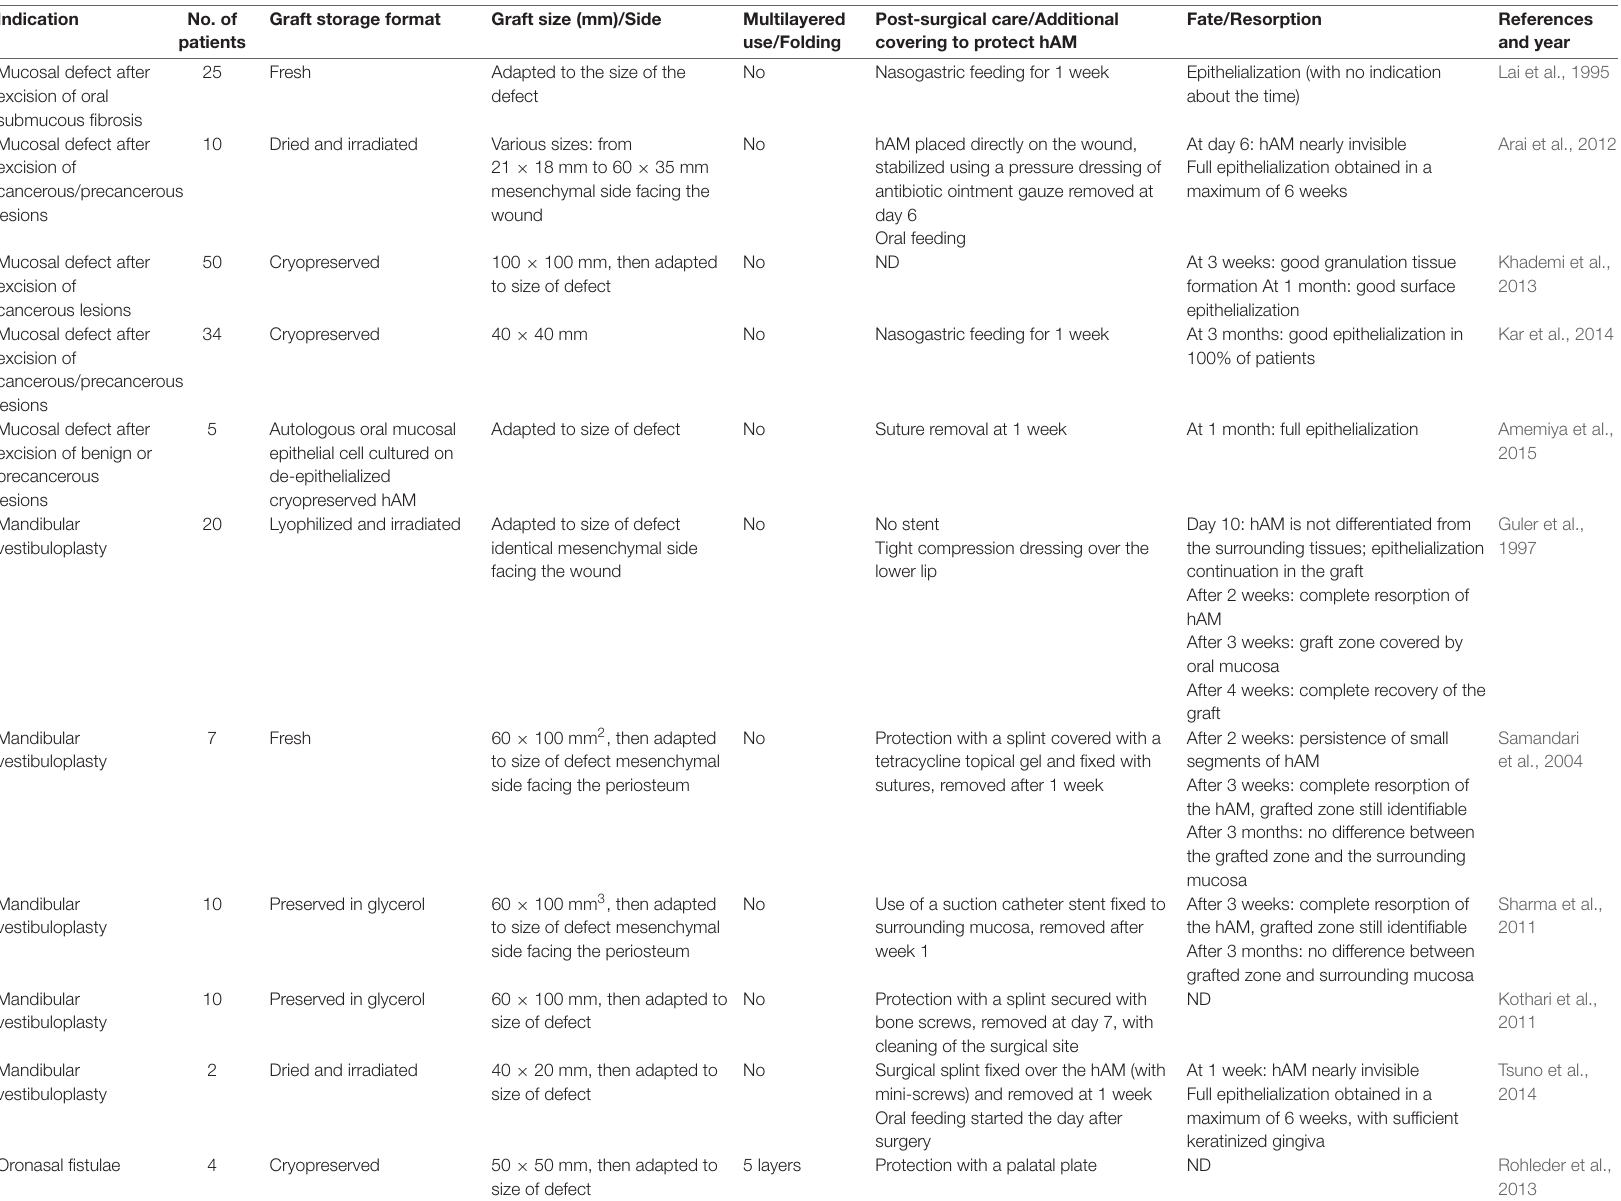
TABLE 2 | hAM used as a covering graft